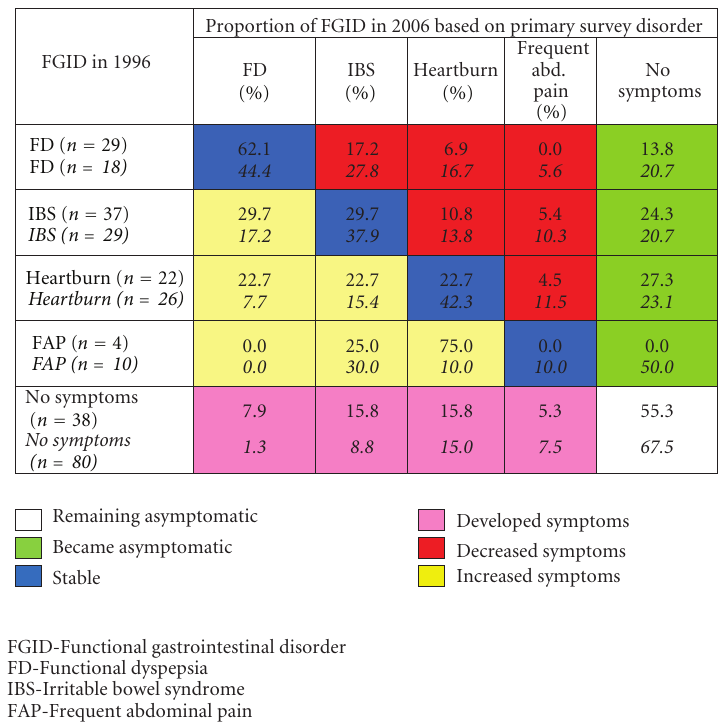
Figure 1: Transitions among symptom subgroups between the initial and final surveys. Women with dysmenorrhea, women without